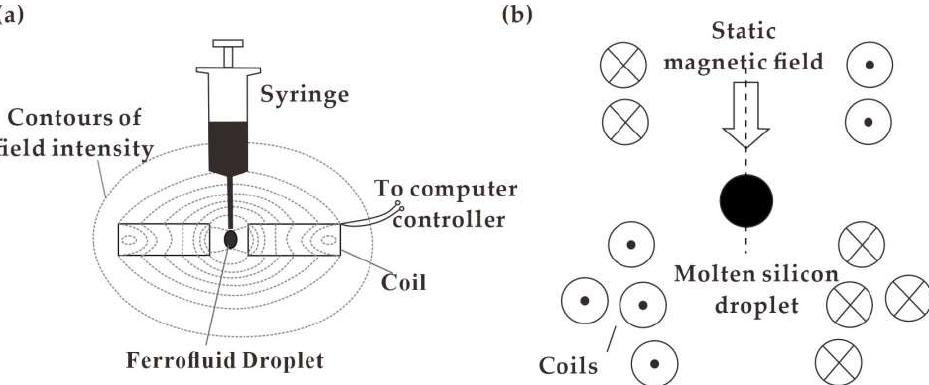
Figure 6. Magnetic levitation of droplets: ( a ) Ferrofluid droplet levitation and splitting in an electromagnetic field [154]; ( b ) Molten silicon droplets levitation in a coupled field [161].